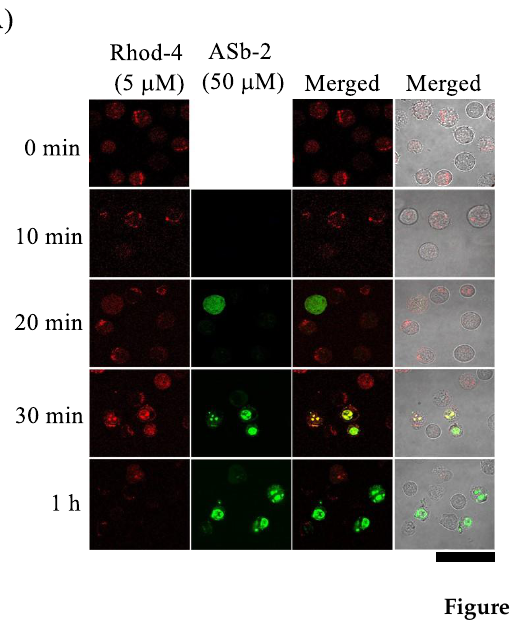
Figure 6. ( A – C ) Flow cytometric analysis of Jurkat cells stained with Rhod-4/AM (5 µM), followed by treatment with ASb-2 (50 µM) at 37 °C. ( D – F ) Flow cytometric analysis of Jurkat cells stained with Rhod-2/AM (5 µM), followed by treatment with ASb-2 (50 µM) at 37 °C. ( G – I ) Flow cytometric analysis of Jurkat cells that had been treated with celastrol (30 µM) and stained with Rhod-4/AM (5 µM) at 37 °C. ( J – L ) Flow cytometric analysis of Jurkat cells that had been treated with celastrol (30 µM) and stained with Rhod-2/AM (5 µM) at 37 °C.